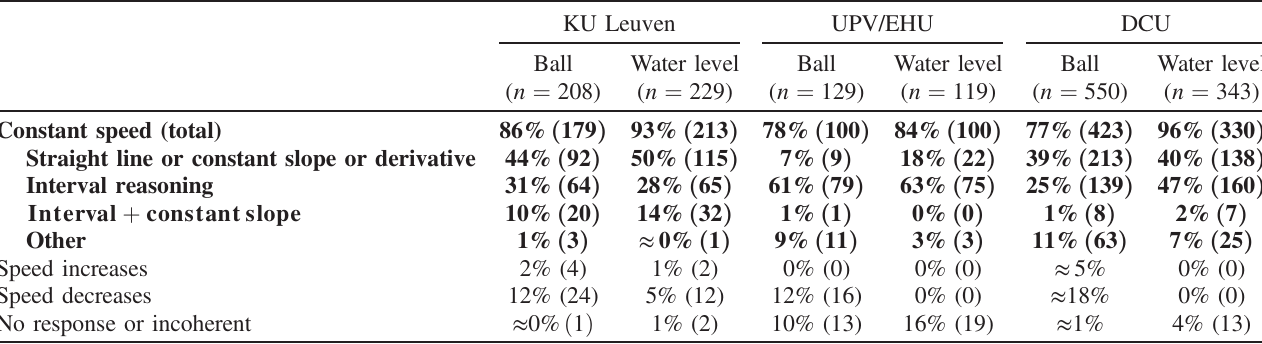
TABLE I. Categorization and prevalences of approaches to determining whether the speed of the ball or rate of change of the water level is constant, increasing, or decreasing. Correct responses (constant speed) are printed in bold, and are subdivided by the argument students used to explain their